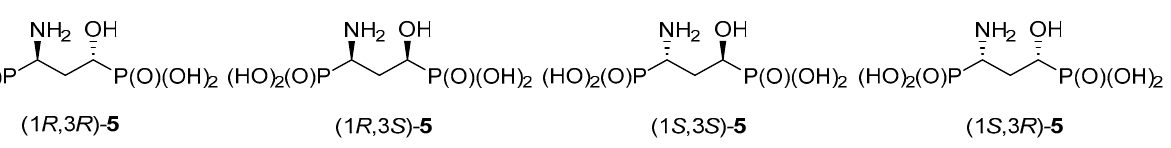
Figure 1. L-Glutamic acid 1 and its active analogues.